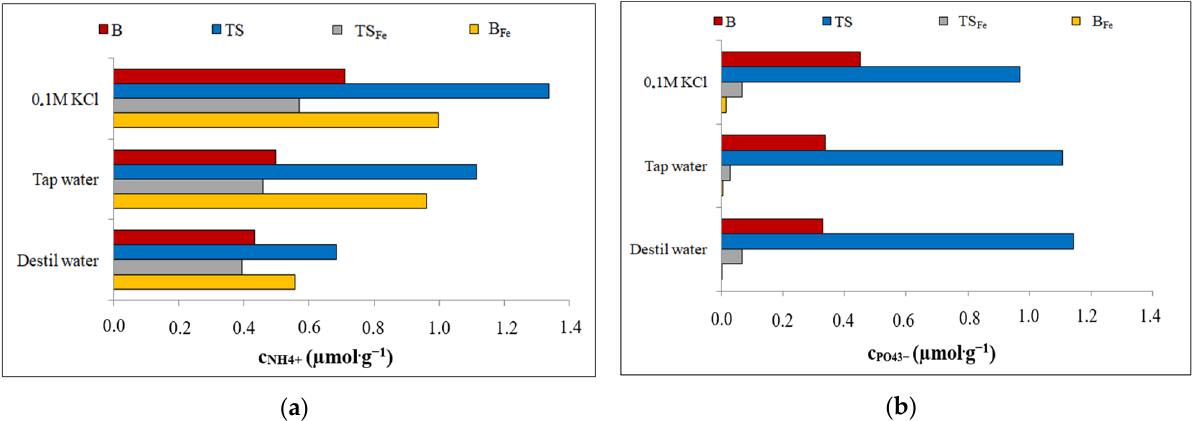
Figure 7. The amount of ion leached from B/B Fe and TS/TS Fe after selected ion adsorption: ( a ) NH 4+ ; ( b ) PO 43 − .